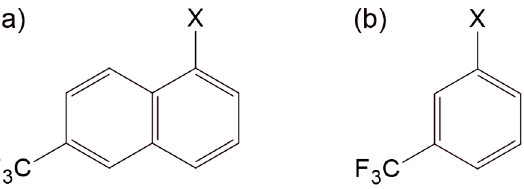
Figure 7. Similarity of 6 ‐ trifluoromethyl ‐ 1 ‐ X ‐ naphthalene 1 ‐ 6 ( a ) and m ‐ trifluoromethyl ‐ X ‐ benzene X ‐ ( m ‐ Ph) ‐ CF 3 ( b ).